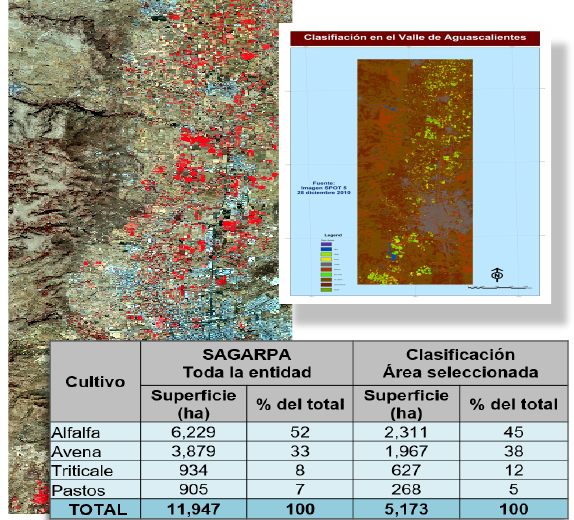
Figure 1. Results obtained by SAGARPA and